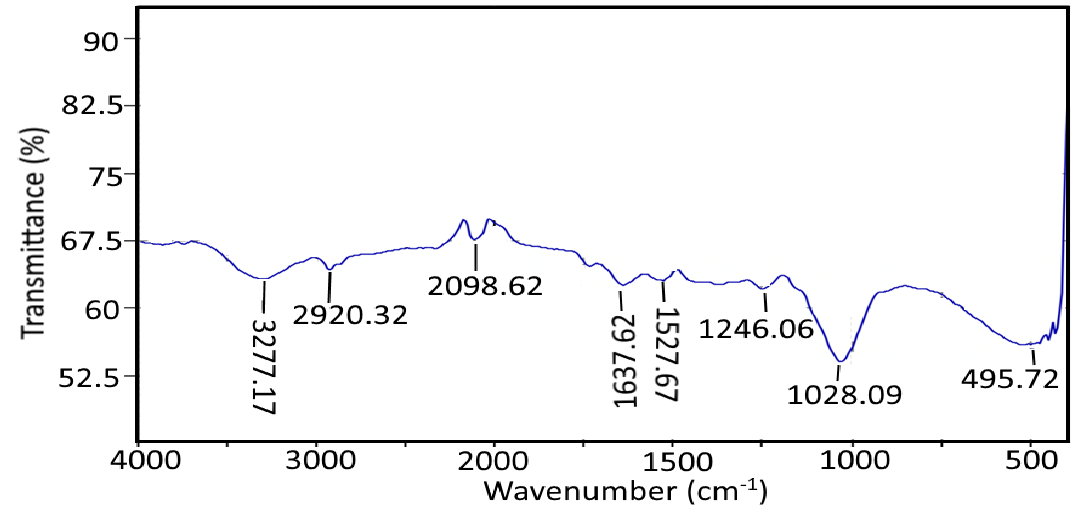
Figure 3. FTIR spectra of corn silk powder.